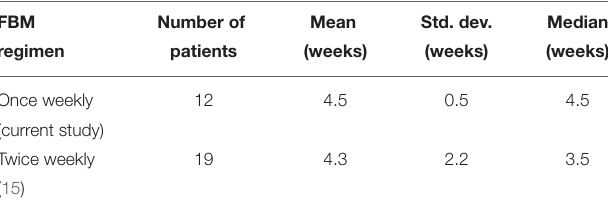
TABLE 4 | Summary of time to clinical resolution between once and twice weekly FBM application.